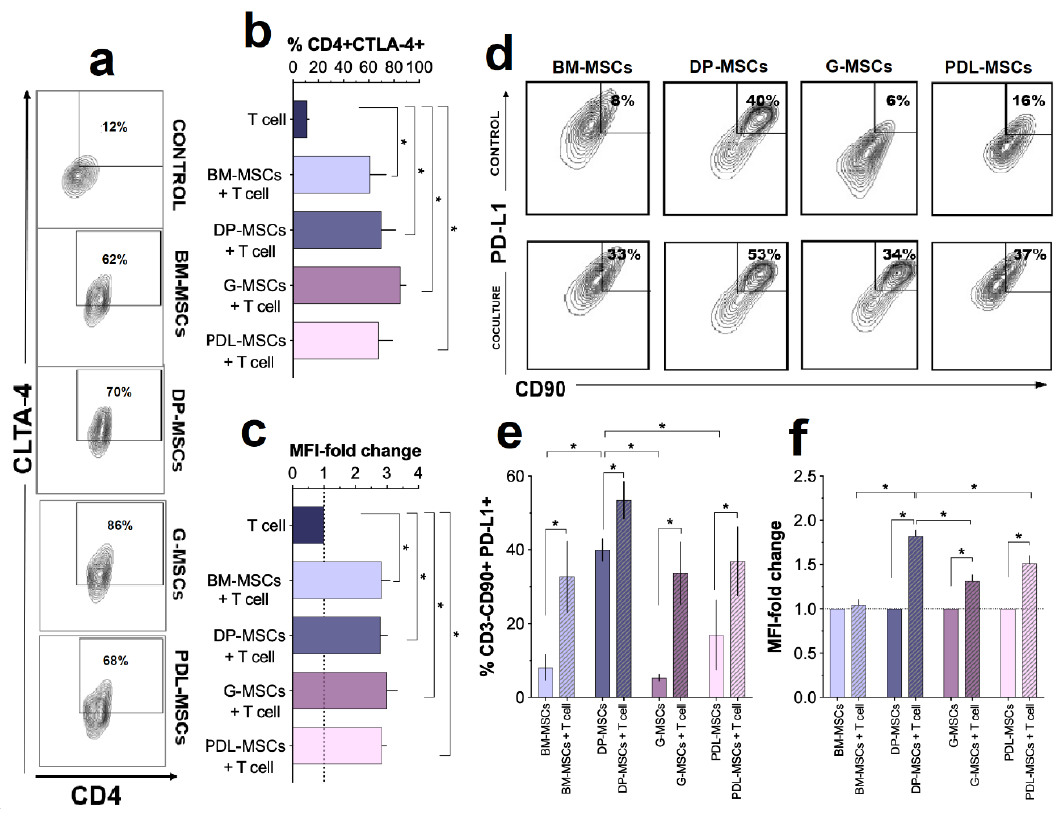
Figure 4. Increased expression of cytotoxic T-cell-associated Ag-4 (CTLA-4) in CD4 + T-cells and programmed death ligand 1 (PD-L1) in MSCs. CD3 + T-cells were activated with anti-CD3/CD28 and cocultured in the presence of BM-MSCs, DP-MSCs, G-MSCs or PDL-MSCs at a 1:1 ratio of MSCs:T-cells. The expression of CTLA-4 in CD3 + CD4 + cells cultured in the absence of MSCs was considered as the basal expression (Control). The percentage of CD3 + CD4 + CTLA-4 + cells and the fold increase in the CTLA-4 mean fluorescence intensity (MFI) were determined in the CD4 + population after four days of culture (n = 5). ( a ) Dot plots are representative of one experiment with the CD3 + CD4 + CTLA-4 + population. ( b ) Data are shown as the mean ± SEM of the percentage of CD4 + CTLA-4 + cells. ( c ) Fold increase in the CD4 + MFI of the CD4 + CTLA-4 + population. PD-L1 expression in MSCs cultured in the absence of activated CD3 + T-cells was considered as the basal expression (Control). The percentage and MFI of PD-L1 + cells were determined in the CD3 - CD90 + population after four days of culture (n = 5). ( d ) Dot plots are representative of one experiment. ( e ) Data are shown as the mean ± SEM of the percentage of CD3 - CD90 + PD-L1 + cells. ( f ) Fold increase in the PD-L1 MFI in the CD3 - CD90 + PD-L1 + population. *Significant difference at p < 0.05.